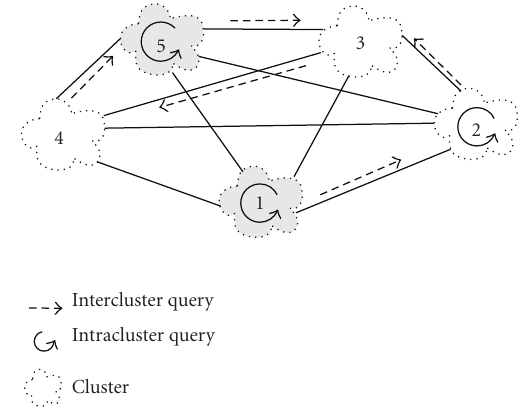
Figure 3: A query scheme mixing intercluster queries and intraclus- ter queries (the nodes in the grey clusters fall into the same interest